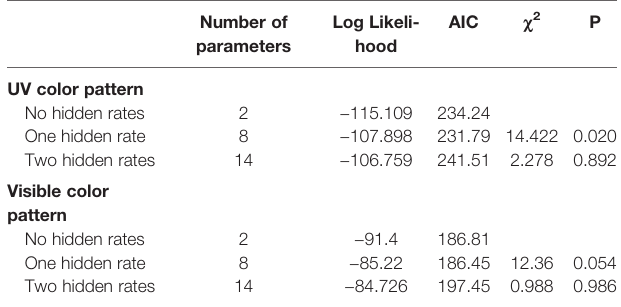
TABLE 1 | Model fi t comparisons of evolutionary transition rates between patterned and non-patterned petals. Number of parameters